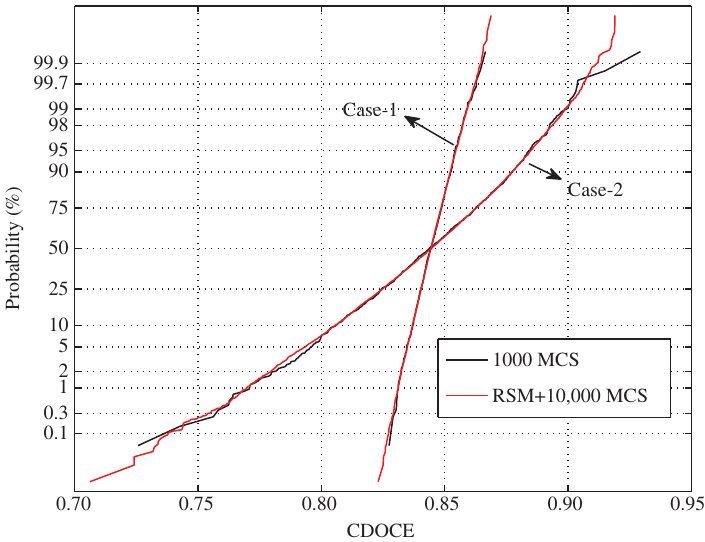
Figure 7 Gauss plots of the CDFs calculated in case 1 and case 2.